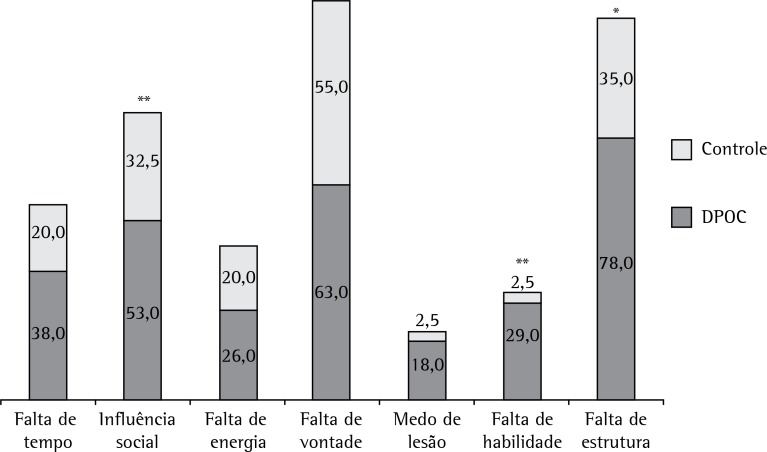
Questionário de barreiras: proporção de participantes com valores = 5
pontos por domínio nos grupos estudados.